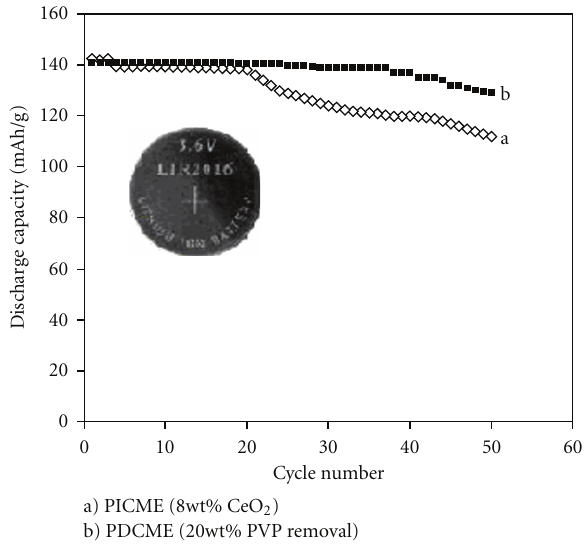
Figure 8: Discharge capacity as a function of cycle number for MCMB/electrolyte/LiCoO 2 cells at 25 ◦ C with discharge rate of C/2; (a) PICME and (b)